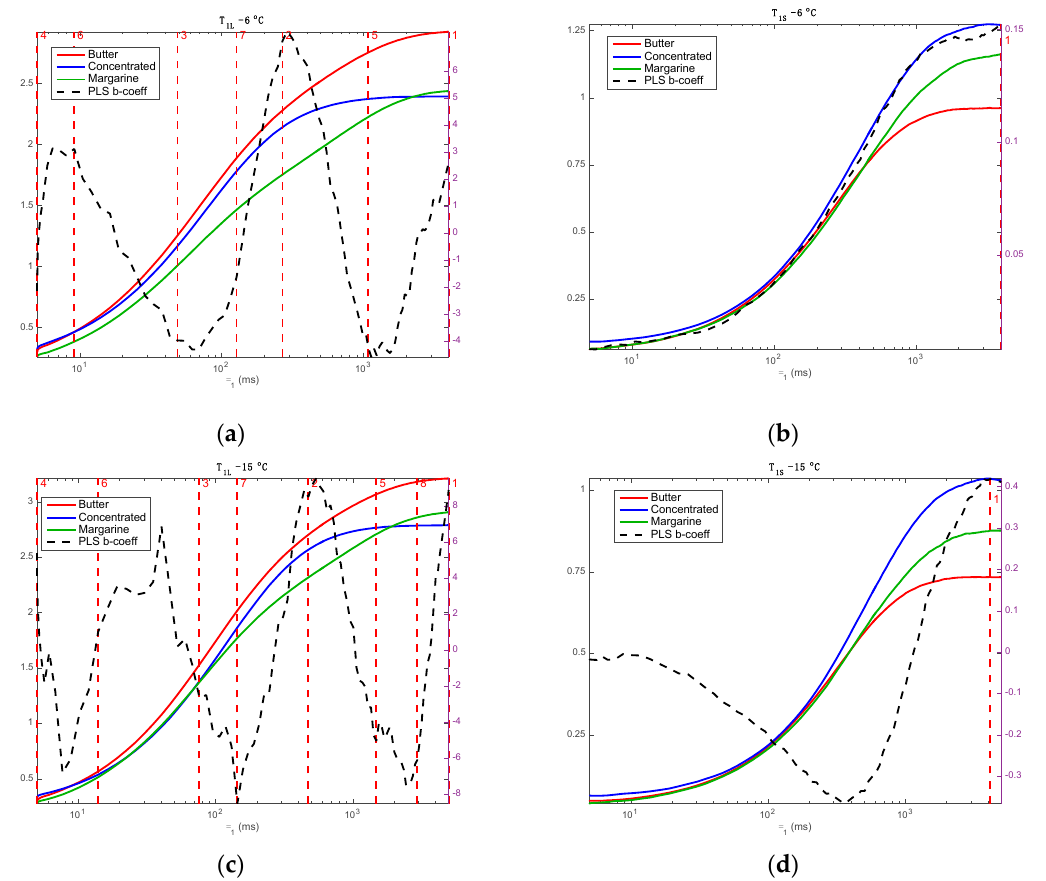
Figure 4. SO-PLS b-coefficients and variables selected by SO-CovSel, superimposed to the product mean spectra. Left ( a , c ): For T 1L signals. Right (b, d): For T 1S signals. Top ( a , b ): T=6 °C. Bottom ( c , d ): T=15 °C. Horizontal scale is logarithmic. Vertical dashed red lines show the relaxation times selected by CovSel.